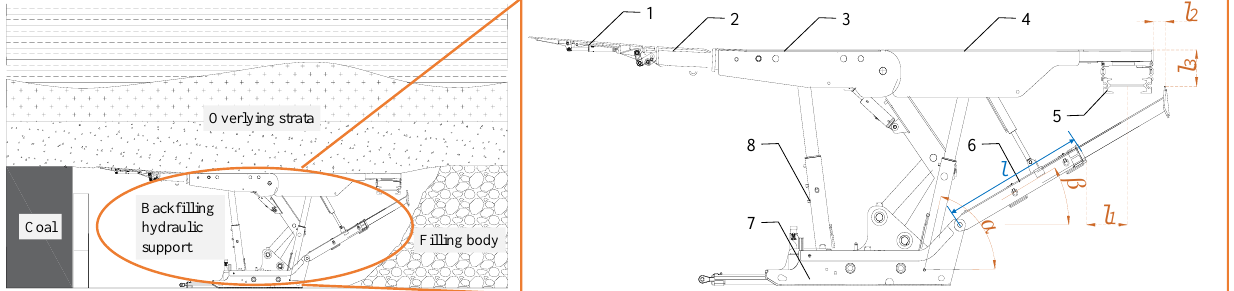
Figure 1. Environmental protection of solid filling coal mining: ( a ) caving mining; ( b ) solid backfill mining; ( c ) basic principle of solid backfill mining.